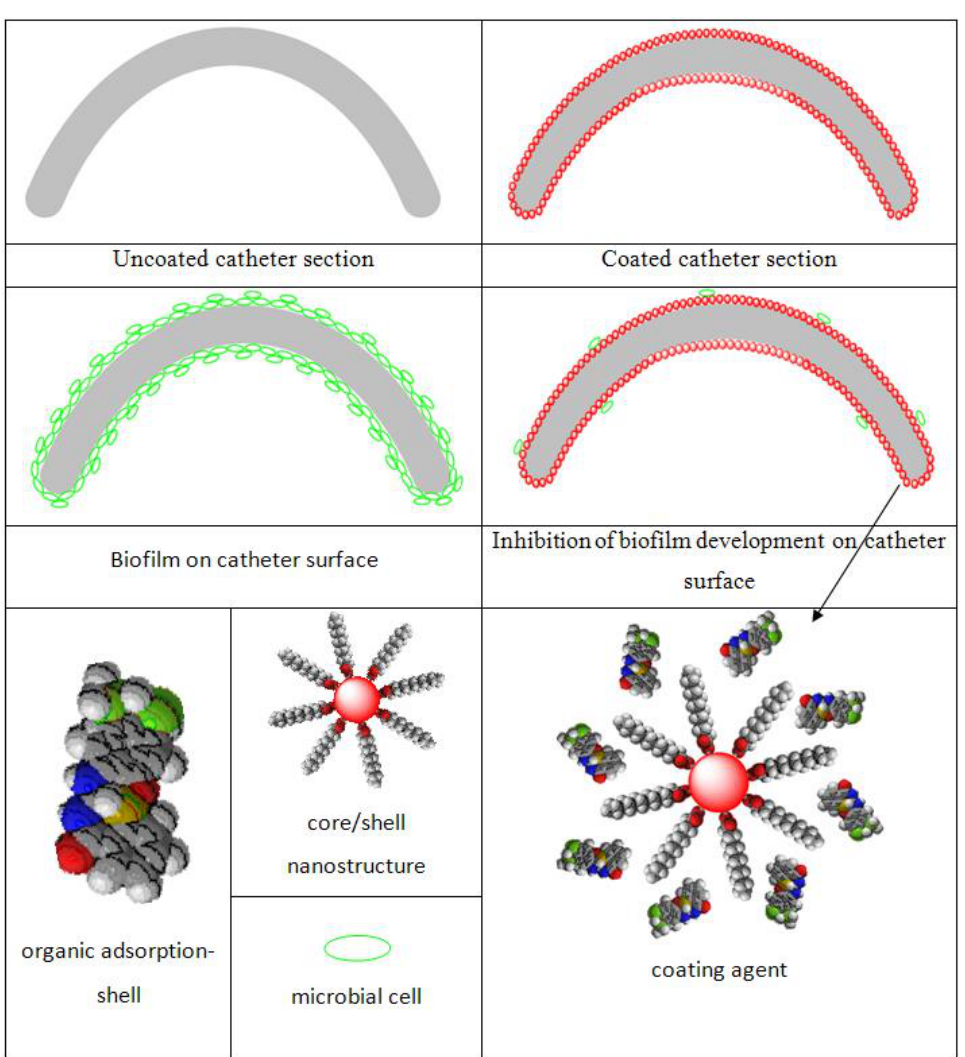
Figure 1. Schematic illustration of biofilm development in the presence / absence of the coatings [64]. Reprinted from an open access source.